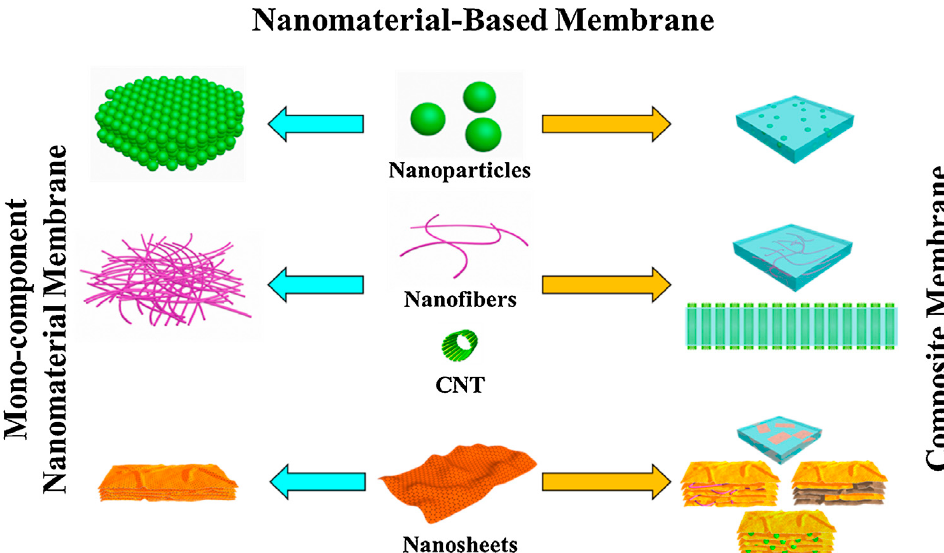
Figure 2. Membranes fabricated with nanomaterials, such as mono-component nanomaterial membranes fabricated with the integration of nanoparticles, nanofibers, carbon nanotubes, and nanosheets, and their composites (in conjunction with unique polymeric or inorganic materials) (Adapted from Ref. [37], with consent from Elsevier).